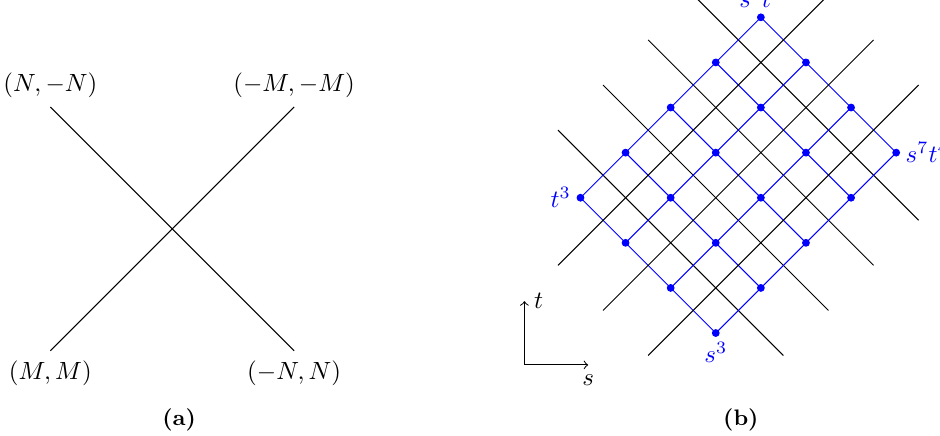
Figure 6. Left: the 5-brane junction describing the X N;M SCFT. Right: brane web and grid diagram for a mass deformation of the X 4 ; 3 theory (a complete triangulation of the grid diagram can be obtained by resolving the remaining brane